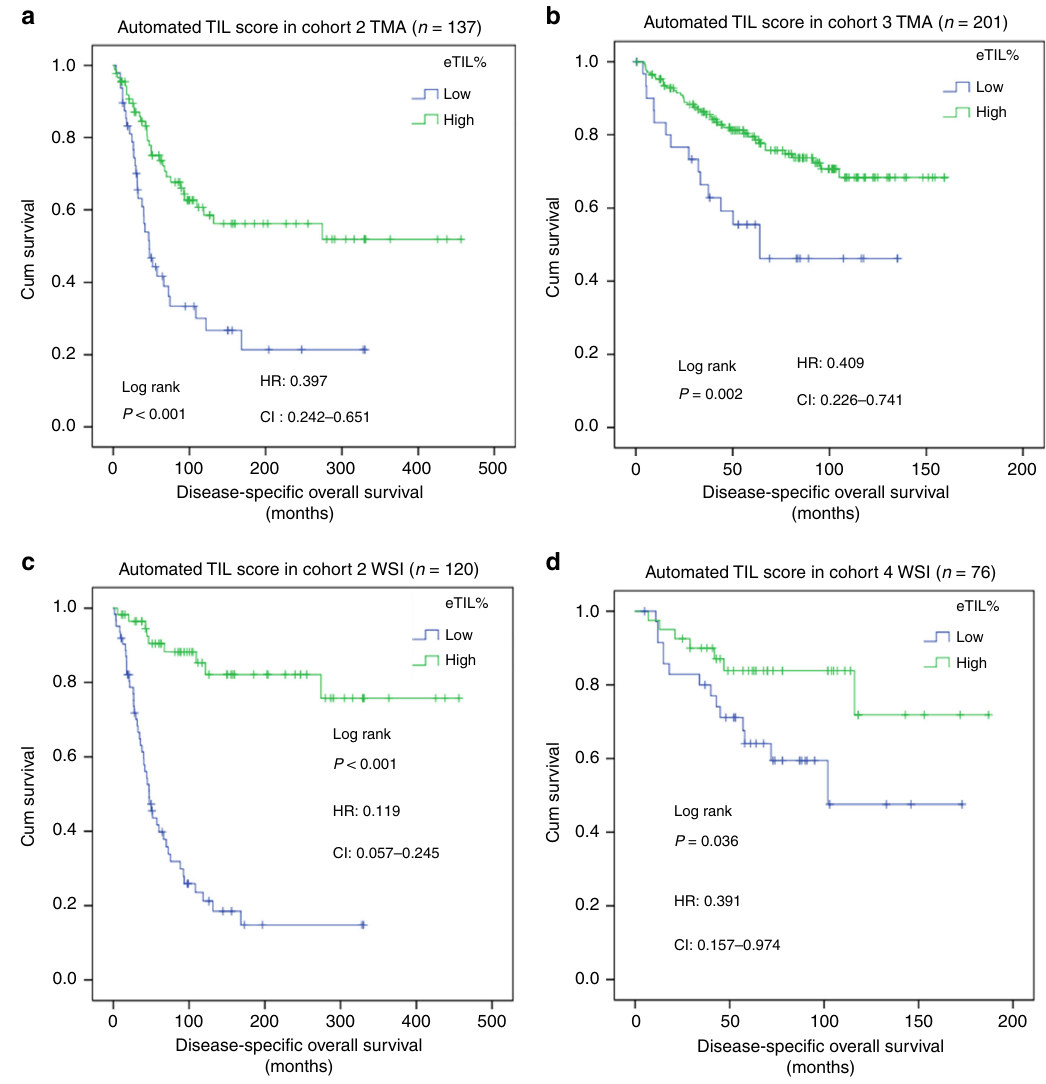
Fig. 2 Validation of automated tumor-in fi ltrating lymphocytes (TIL) algorithm in three independent cohorts. The prognostic potential of automated TIL scores performed on tissue microarray (TMA slides) ( a , b ) and whole slides ( c , d ) in cohorts #2, #3, and #4.